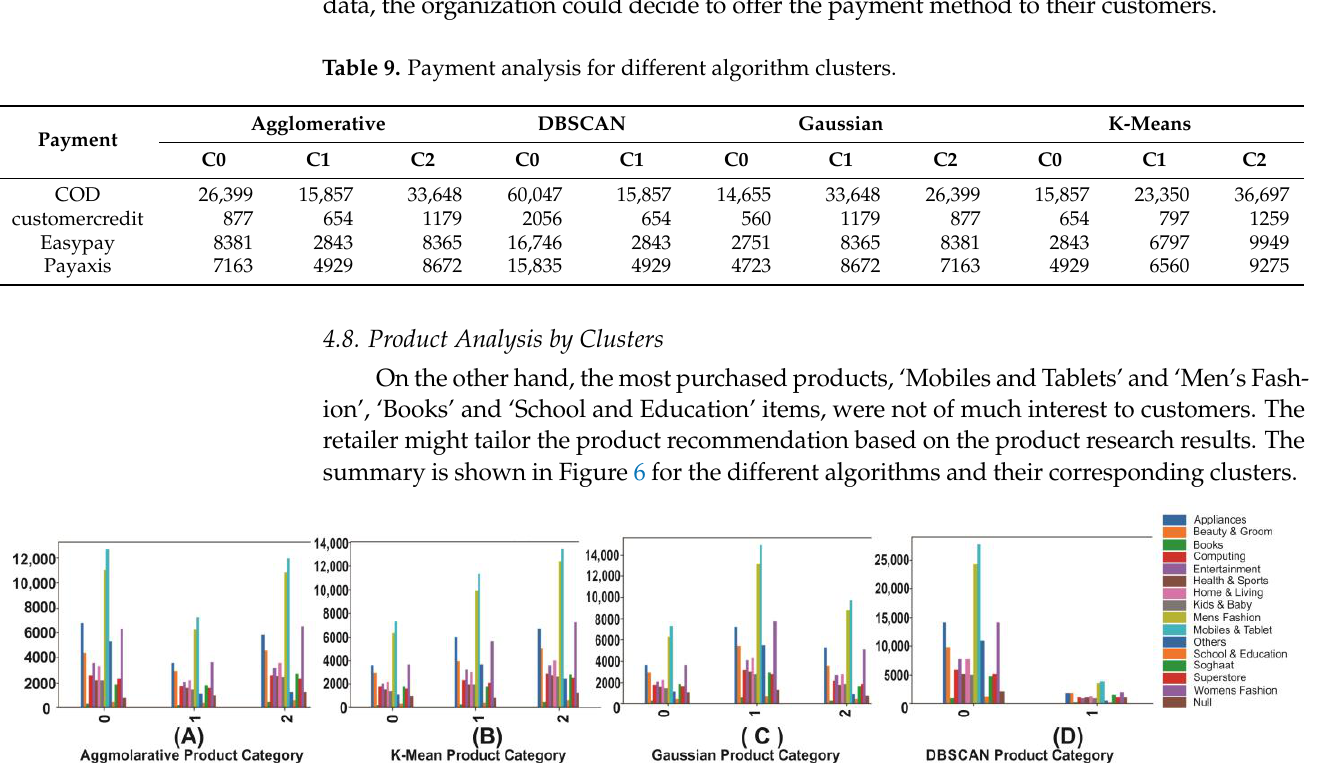
Table 8. Transaction status analysis value for different algorithm’s clusters.